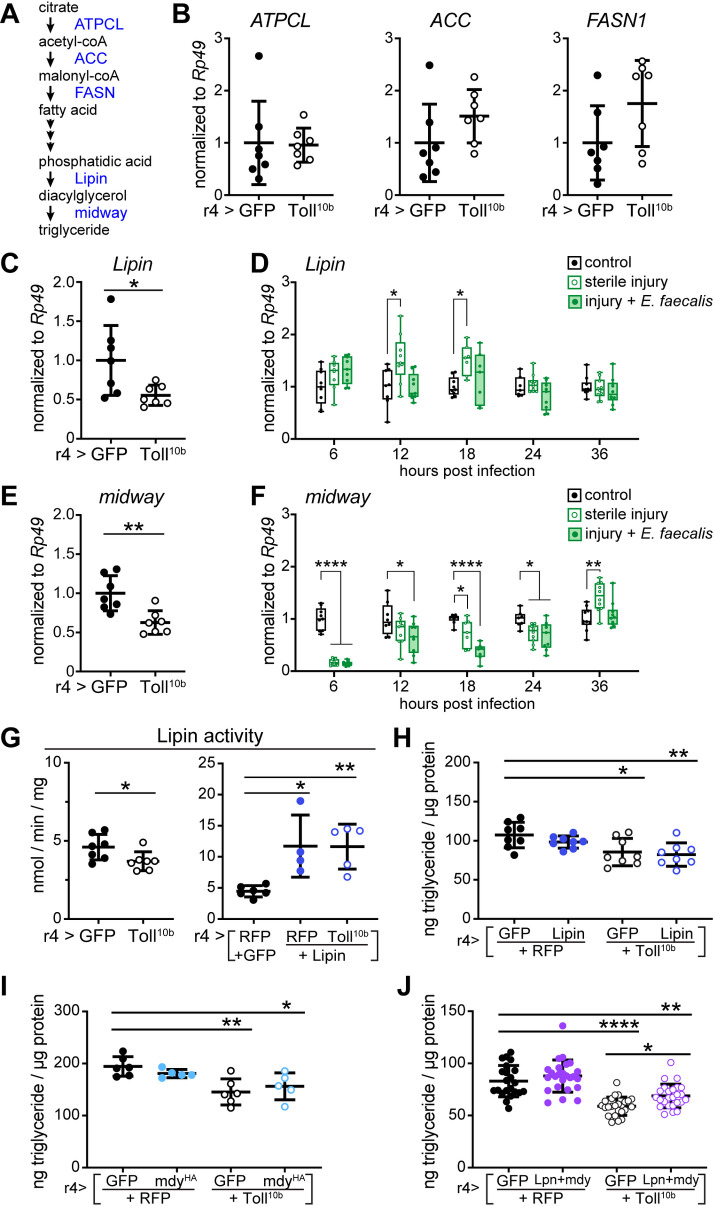
Reduced expression of Lipin and the DGAT homolog midway correlate with low triglyceride levels in larvae with active Toll signaling.(A) Schematic representation of the de novo lipogenic pathway leading to triglyceride synthesis. (B-F) Total RNA was extracted from late third instar larval fat bodies expressing the indicated transgenes under control of r4-GAL4 or fat bodies from control, injured, and infected larvae dissected at indicated times following sterile injury or infection with Enterococcus faecalis early in the third instar stage. All transcript levels were measured by RT-qPCR and normalized to Rp49. (B) ATPCL, ACC, and FASN1 transcripts in late third instar larval fat bodies expressing GFP or Toll10b, n = 7/group. (C) Lipin mRNA levels in late third instar larval fat bodies expressing GFP or Toll10b, n = 7/group. *p = 0.0259 versus GFP. (D) Lipin mRNA levels in third instar larval fat bodies at 6–36 hours post infection, n = 7-10/group. *p ≤ 0.0133 versus uninfected controls. (E) midway mRNA levels in late third instar larval fat bodies expressing GFP or Toll10b, n = 7/group. **p = 0.0031 versus GFP. (F) midway mRNA levels in third instar larval fat bodies at 6–36 hours post infection, n = 7-10/group. *p ≤ 0.0350, **p ≤ 0.0017, and ****p < 0.0001 versus uninfected controls. (G) Lipin activity in fat bodies from late third instar larvae expressing GFP or Toll10b (left) and RFP+GFP, RFP+Lipin, or Toll10b+Lipin (right) under control of r4-GAL4, n = 4-7/group. *p ≤ 0.0179 versus GFP (left) or RFP+GFP (right) and **p = 0.0097 versus RFP+GFP. (H) Triglyceride levels in late third instar larvae expressing Toll10b with or without a wild type Lipin transgene in fat body, n = 8/group. *p = 0.0164 and **p = 0.0053 versus RFP+GFP. (I) Triglyceride levels in late third instar larvae expressing Toll10b with or without a wild type mdyHA transgene in fat body, n = 5-6/group. *p = 0.0193 and **p = 0.0020 versus RFP+GFP. (J) Triglyceride levels in late third instar larvae expressing Toll10b with or without wild type Lipin and mdyHA transgenes in fat body, n = 22-25/group. **p = 0.0016 and ****p < 0.0001 versus RFP+GFP, and *p = 0.0193 versus GFP+Toll10b. Data are shown as means ± SD. p values were determined by Student’s t test (B, C, E and G, left panel) and one-way ANOVA with Dunnett’s (D, F, H, I) or the Tukey-Kramer (G, right panel, J) multiple comparisons test.